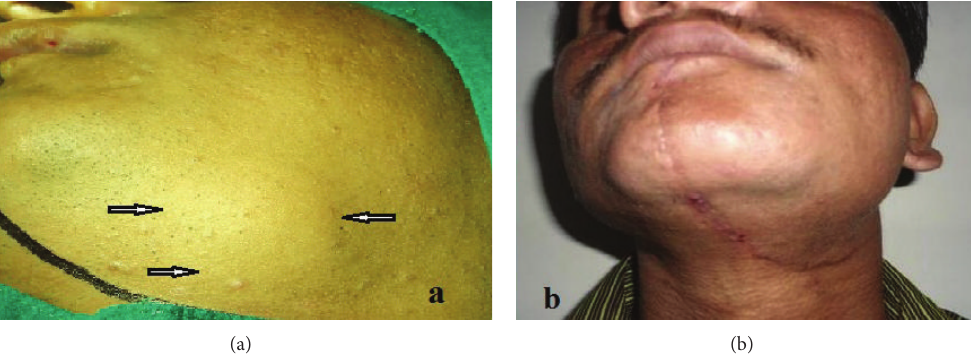
Figure 1: (a) Extraoral picture of the patient showing swelling in the left submandibular region. (b) Extraoral picture after 1year of followup.